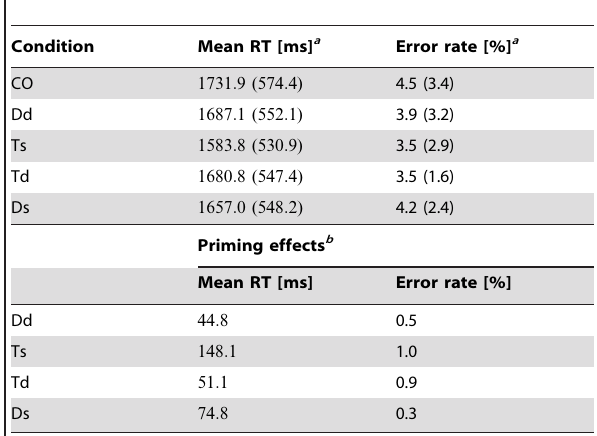
Table 3. Summary of results of Experiment